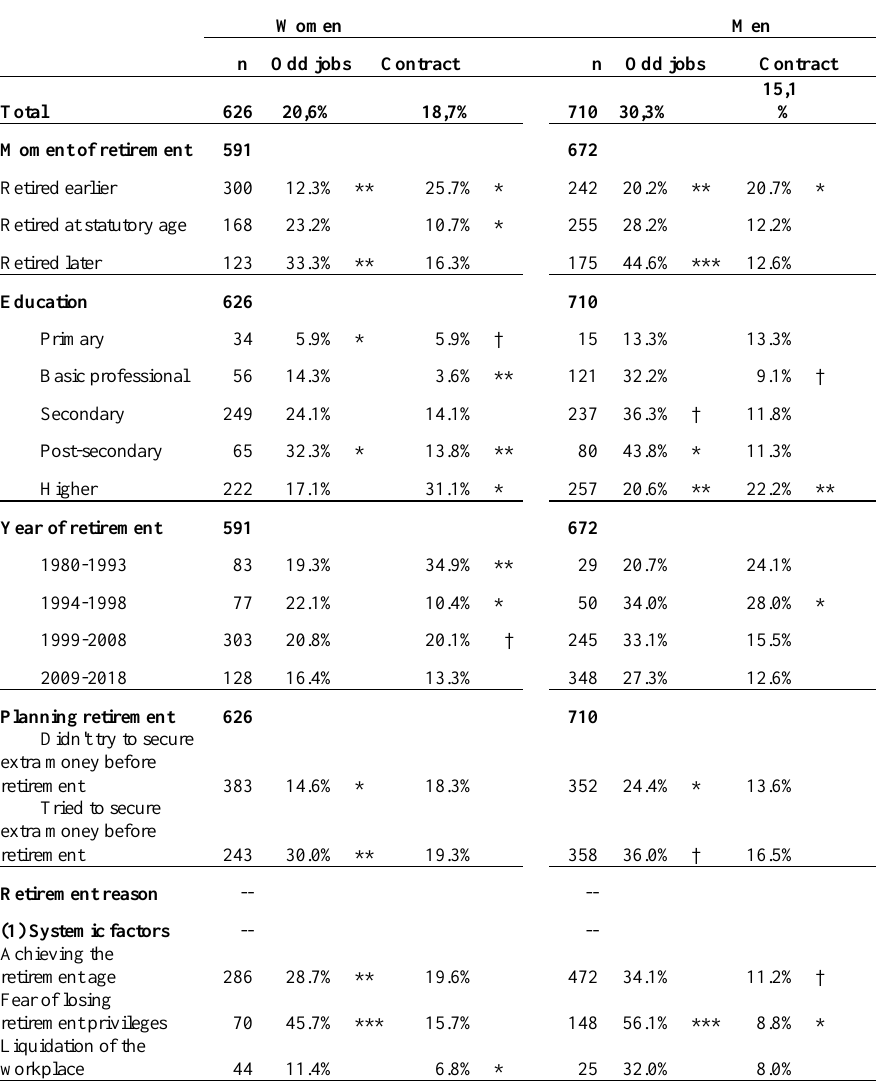
Table 1. Structure of the examined sample by chosen variables